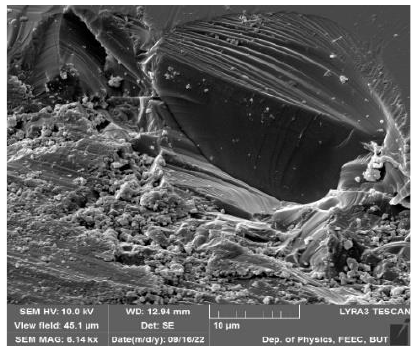
Figure 13. Sample of deposited BFO material. Thin films of BFO material show an absorption rate of the wide visible light range of 350 and 575 nm (Figure 14). The wide visible light spectrum means the material can absorb huge amount of light energy [43].